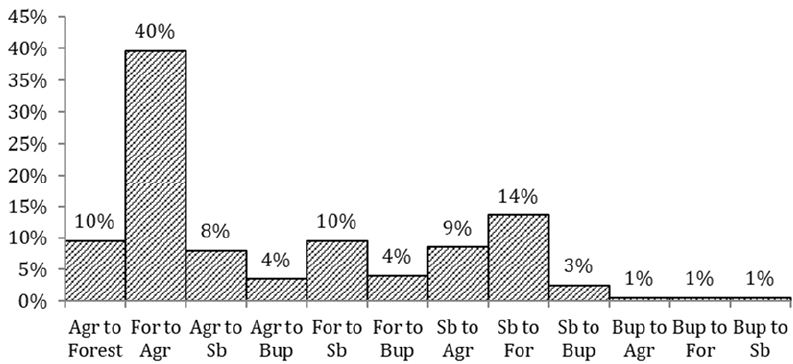
Figure 9. Perception of people for the future change in land